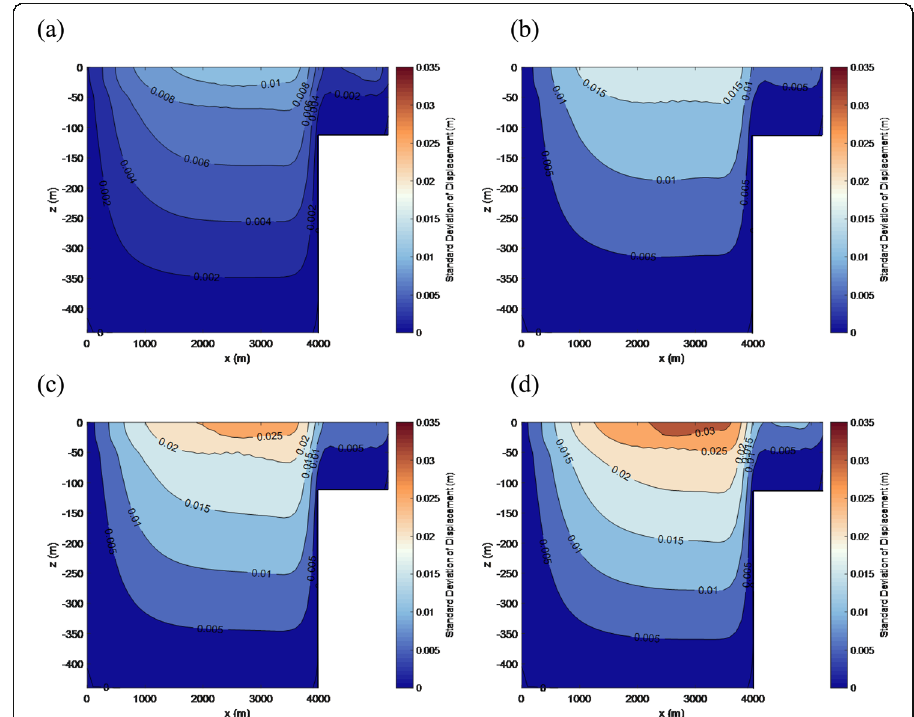
Fig. 8 Effects of the correlation length of k a on the uncertainty of displacement. a l x = 200 m, l z = 40 m. b l x = 400 m, l z = 80 m. c l x = 600 m, l z = 120 m. d l x = 800 m, l z = 160